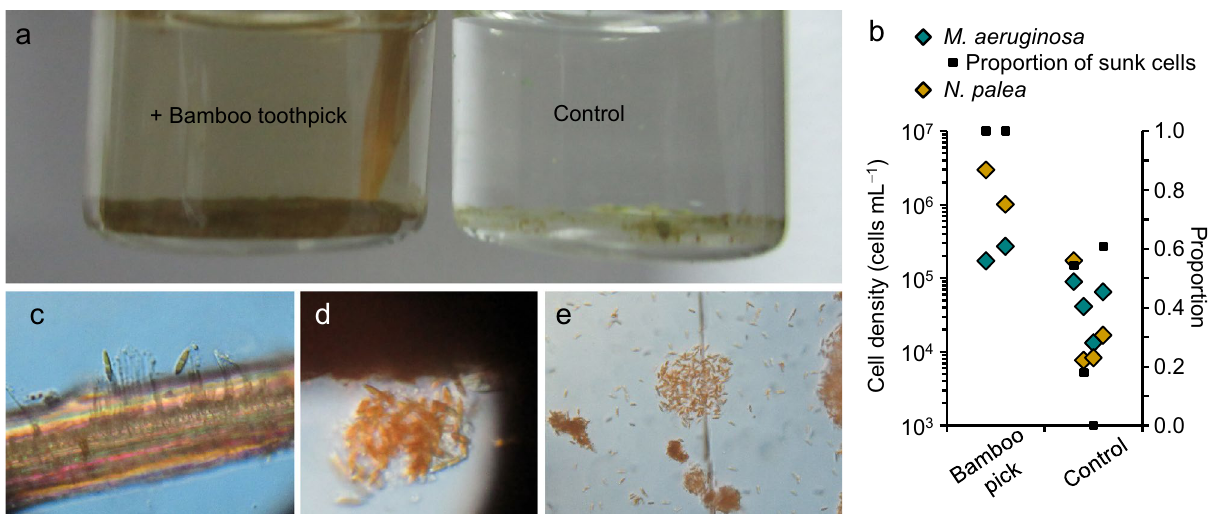
Figure 6. Algal responses to bamboo toothpick in culture ( a : experiment culture, b : cell density of Microcystis aeruginosa and Nitzschia palea with the proportion of sunk cells for M. aeruginosa , c – e : microscopic observation of N. palea attached on bamboo fragments individually and as a